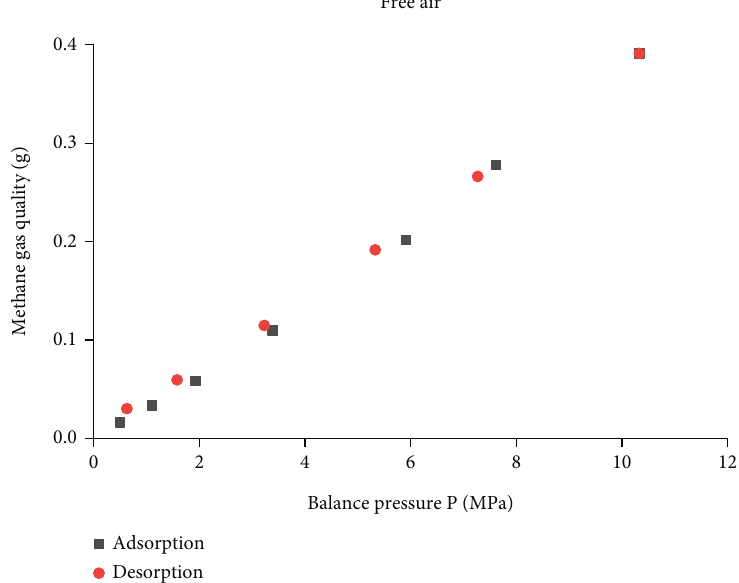
Figure 8: Free gas content at di ff erent